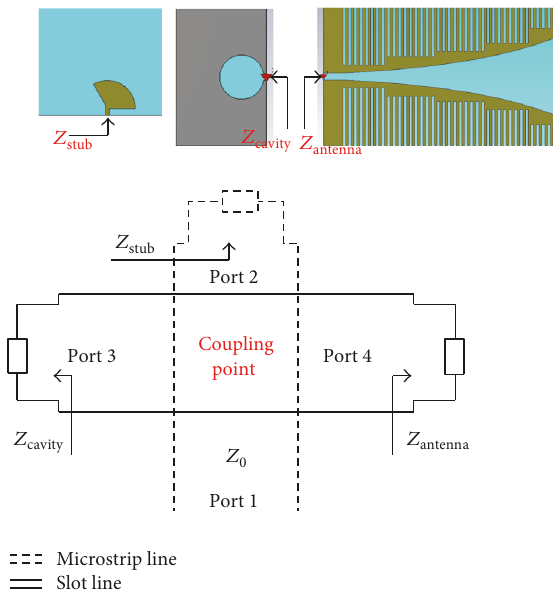
Figure 2: The network for the equivalent circuit of Vivaldi